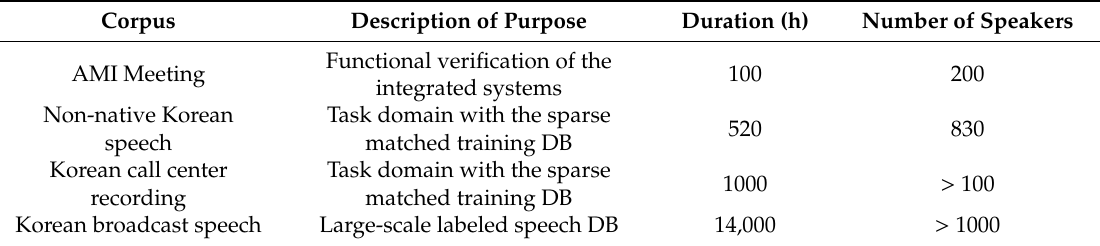
Table 1. Summarization of the corpora used for the